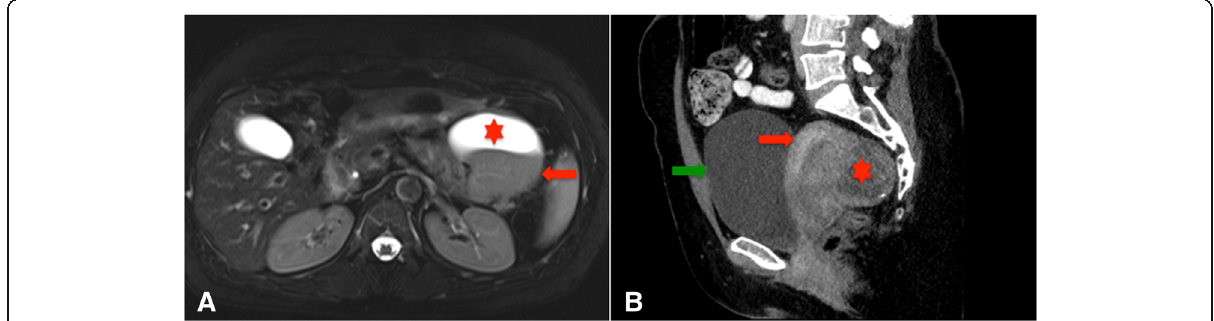
Fig. 1 a (T2 axial image, MRI abdomen/pelvis); An MRI of abdomen and pelvis disclosed an 8 cm solid and cystic mass in the tail of the pancreas, which had a solid component (red arrow), as well as a hemorrhagic component (red *). b (sagittal image, CT of pelvis); A CT of pelvis confirmed a fibroid uterus, with a solid appearance to the lesions (green arrow, bladder; red arrow, uterus; red *, the largest uterine